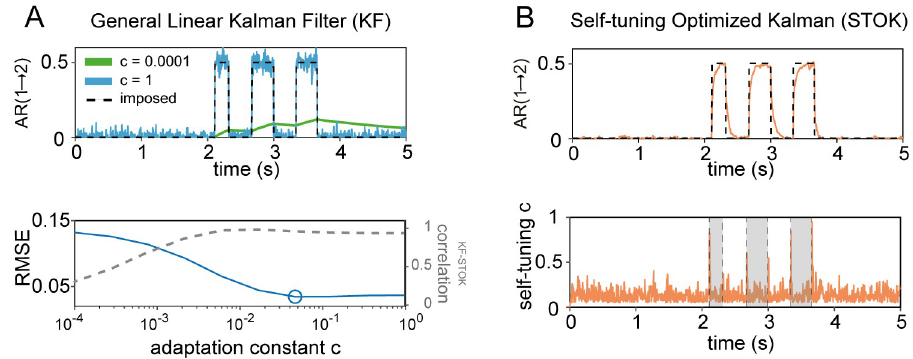
Fig 1. Performance of KF and STOK on a simple simulated bivariate AR(1) process. (A) Performance of the KF filter at recovering the imposed structure of AR coefficients (top panel; black dashed lines) under two extreme values of the adaptation constant ( c = 0.0001, c = 1), highlighting the drastic variability of the estimates as a function of c : poor tracking performance is observed at the lowest (green line) and spurious noisy fluctuations at the highest c (blue line). The optimal c that minimizes the root-mean squared error (RMSE, blue line), lies at a point where KF and STOK performance are highly correlated (bottom panel; correlation shown by the grey dashed line). (B) Performance of the STOK filter, showing the high tracking ability and robustness to noise due to the self-tuning memory decay (top panel; orange line) which automatically increases tracking speed at relevant transition points between AR coefficient states (bottom panel; grey